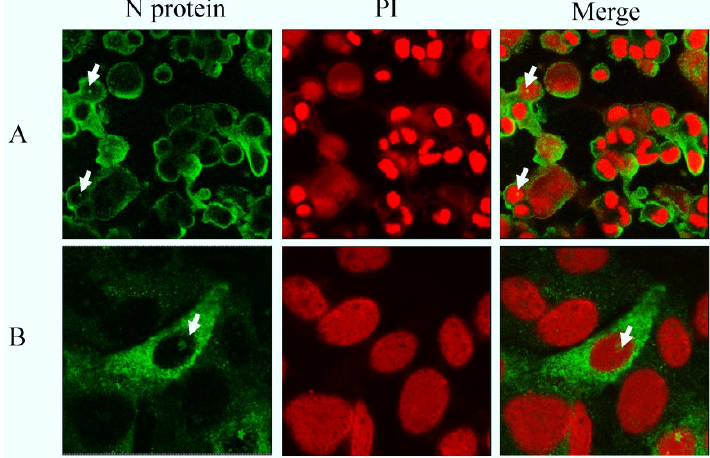
Figure 2. ( A ) Detection of PEDV N protein by indirect immunofluorescence in cells infected with PEDV CV777; ( B ) Detection of PEDV N protein by indirect immunofluorescence in cells transfected with pcDNA3.1 (+)-N. After 24 h, infected or transfected, cells were fixed and analyzed by indirect immunofluorescence using mouse anti-N polyclonal antibody (Green) and stained with PI (red) to visualize the nuclear DNA. Differentially fluorescing images were gathered separately using confocal microscopy. Images were obtained with a 63× oil